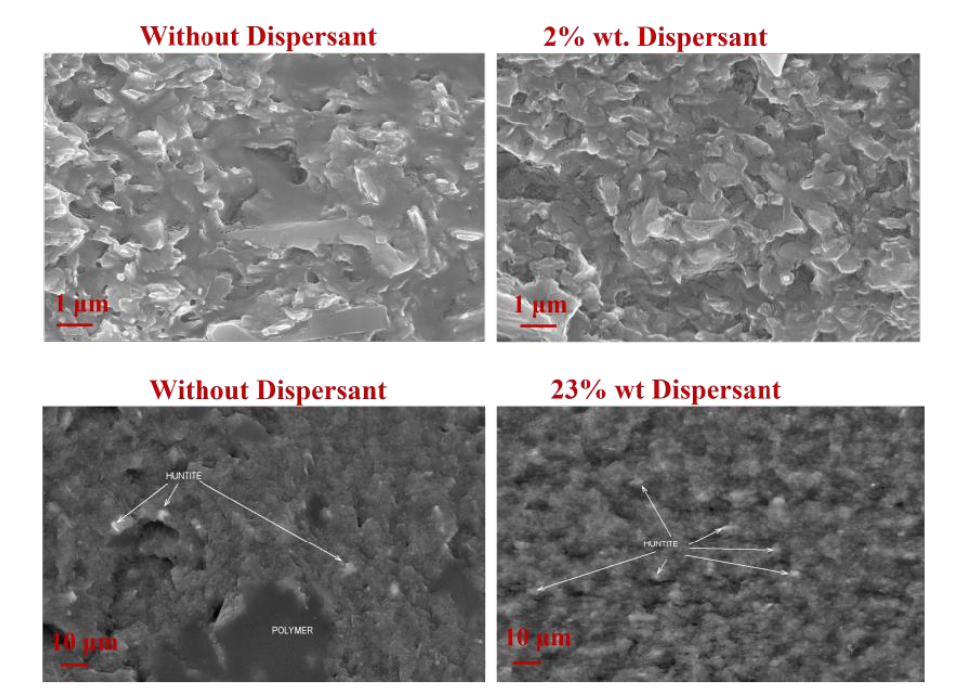
Figure 7. SEM observation of Ecrovin/H5/P(SSH-co-SSBTPB60) coating. As shown, the good interaction between H5 and the additive led to an improved distribution of the polymer matrix as microvoids were formed. Figure 7 also revealed a high stacking density between the filler and the matrix with a short distance between the